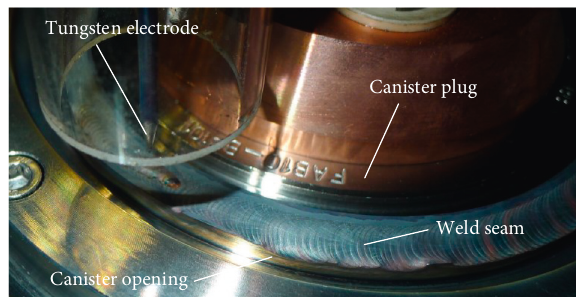
Figure 7: Close-up of the welding torch and the seam during